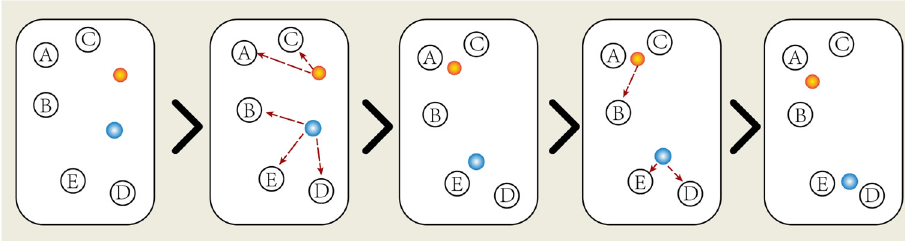
Figure 11. K ‐ means clustering algorithm process.